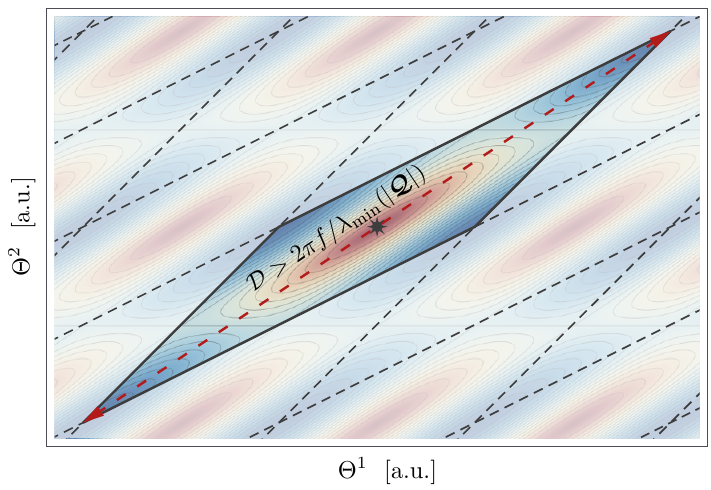
Figure 13 . Illustration of the tile for lattice alignment. The diameter is enhanced by the inverse T of the smallest singular value of the canonical charge